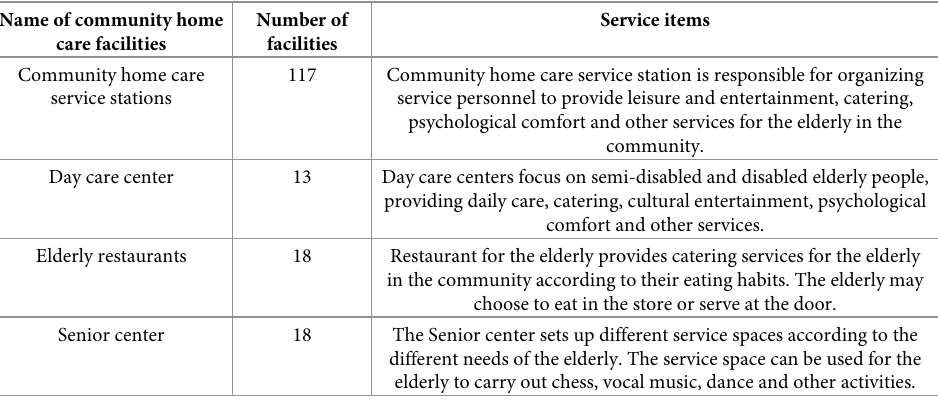
Table 1. An overview of Xi’an community home care facilities.